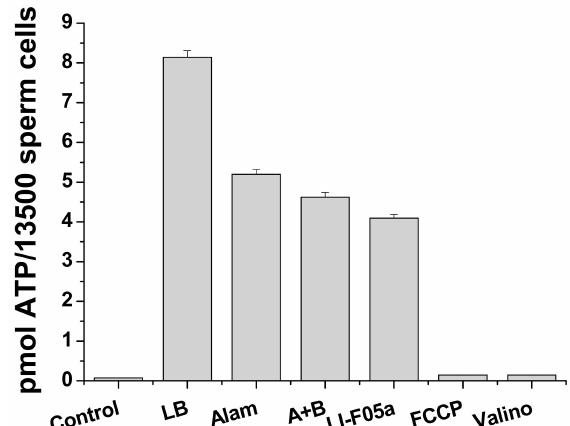
Figure 7. FTCs-induced ATP release from boar spermatozoa. Boar spermatozoa (in standard medium for sperm viability extension) were treated with lysis bu ff er (LB) or exposed to fusaricidins A + B (10.5 µ g / mL), LI-F05a (5.625 µ g / mL), alamethicin (12.5 µ g / mL) (Alam), 500 nM FCCP, and valinomycin (25 ng / mL) (Valino) for 5 min and precipitated. Supernatants were examined for the presence of